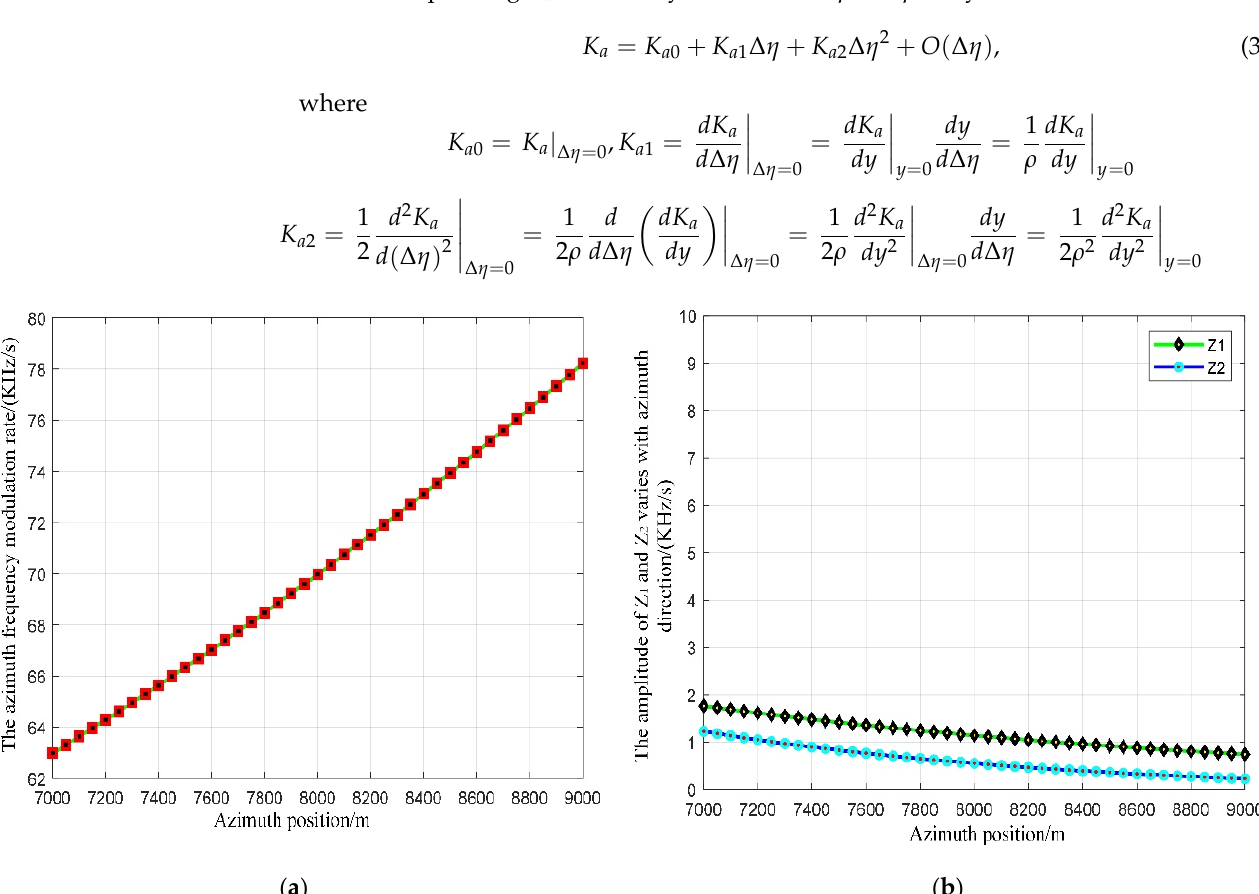
Figure 7. The amplitude varies with azimuth direction. ( a ) The azimuth frequency modulation rate; ( b ) Z 1 and Z 2